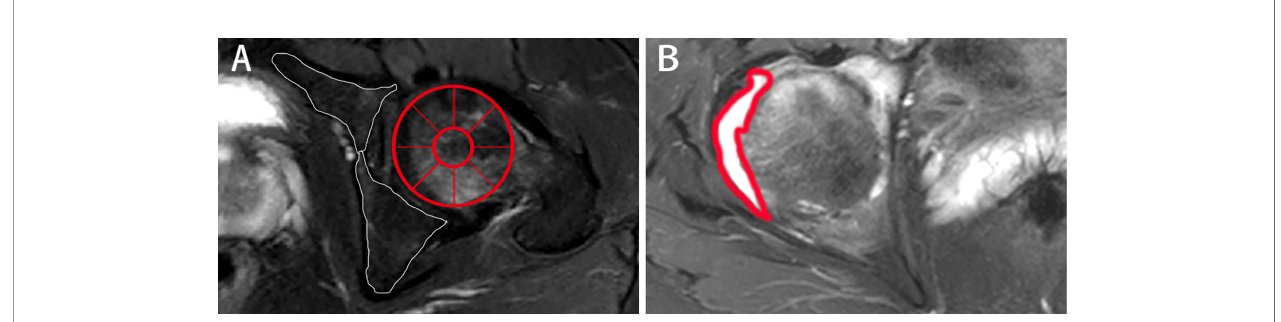
FIGURE 2 | The scoring system on axial MRI in axSpA patients with hip involvement. (A) BME assessment in the two regions of left acetabulum delineated by white line and the nine regions of left femoral head segmented by red line is shown on SPAIR imaging, respectively. (B) Effusion assessment in the right hip is outlined by the thick red line on SPAIR imaging. AxSpA, Axial spondyloarthritis; BME, Bone marrow edema; SPAIR, Spectral attenuated